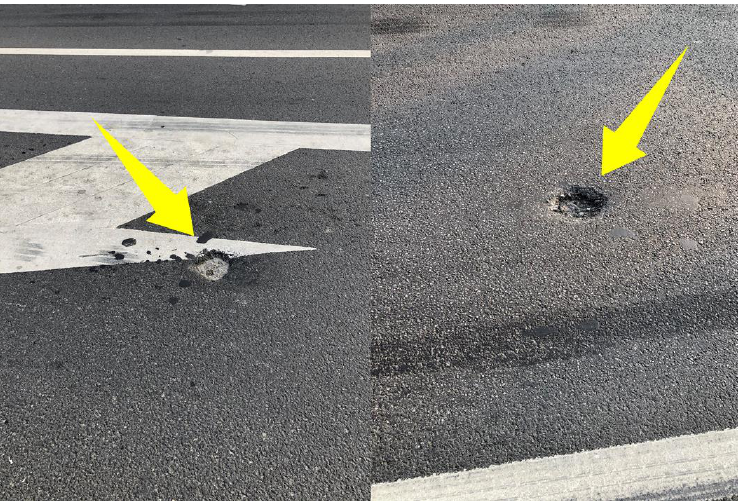
Figure 15. Pothole defects at the junctions of test road